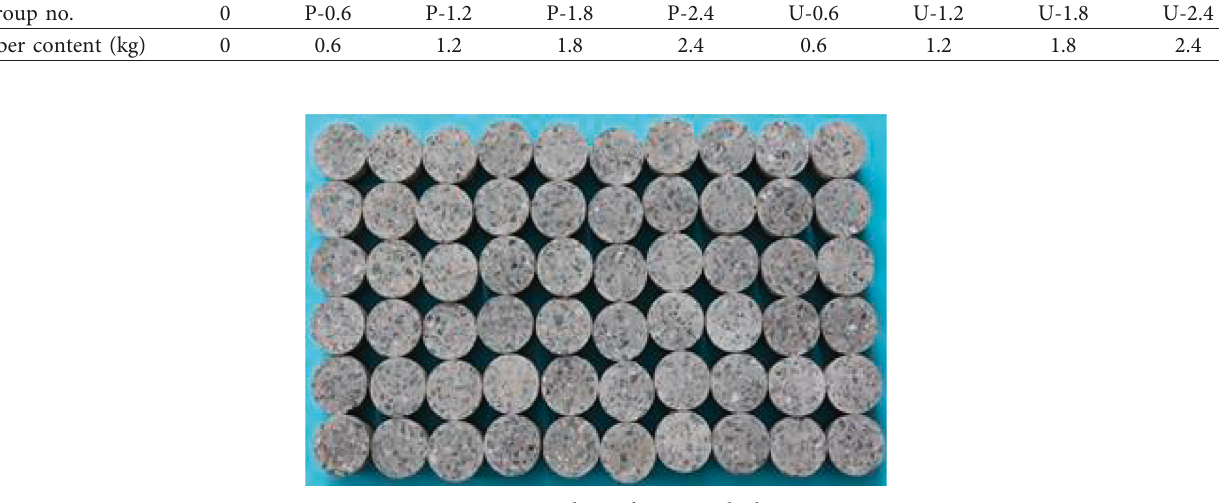
Figure 2: Test samples with 37mm thickness. Table 3: Compressive strength (MPa) of each group of fiber